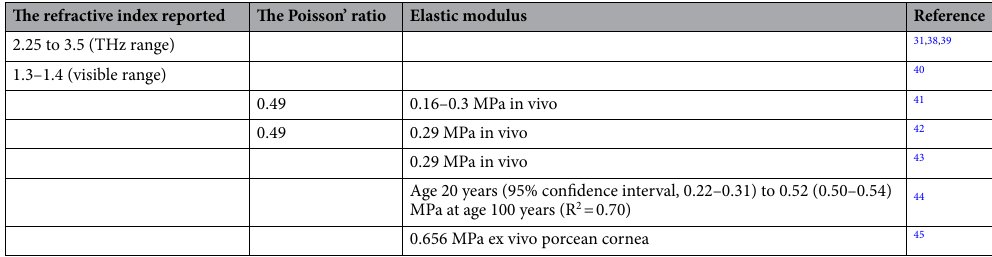
Table 2. The parameters used for calculation of corneal thickness and Young’s modulus.